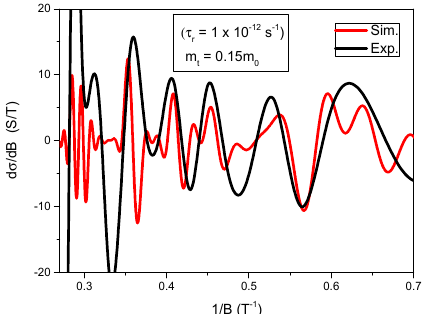
Figure 11. Experimentally measured and calculated SdH oscillations. Measurements of d σ /dB were carried out at T = 380 mK. Calculations were performed by applying Equation (13).